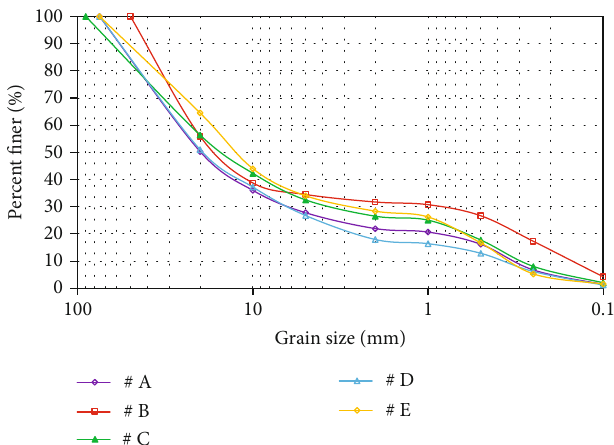
Figure 1: Grading curve of natural sandy gravels numbered A ~ E.